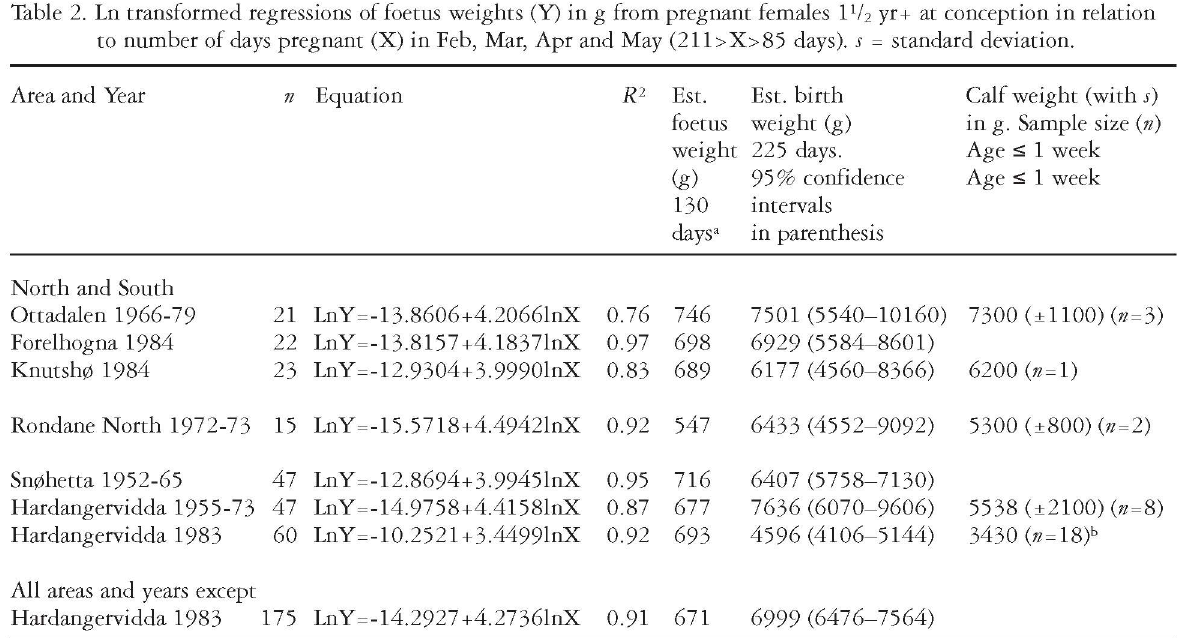
Fig. 4. Comparison of regression curves from Fig. 3. Regression coefficient estimates ±95% con¬ fidence intervals (CI) calculated on basis of Hardangervidda 1983 (dashed line) and regression equations in Table 2. total sample - Hardangervidda 1983 (solid line). Equations are from Table 2. Differences in regression slopes were evaluated from regression coefficients ±95% confidence limits and from analysis of variation (Nissen, 1994). Results Pregnant female dressed weights differed in the vari¬ ous areas as did the mean calving dates (Table 1). Foetus weights plotted against number of days preg- Table 2. Ln transformed regressions of foetus weights (Y) in g from pregnant females 1 1 /2 yr+ at conception in